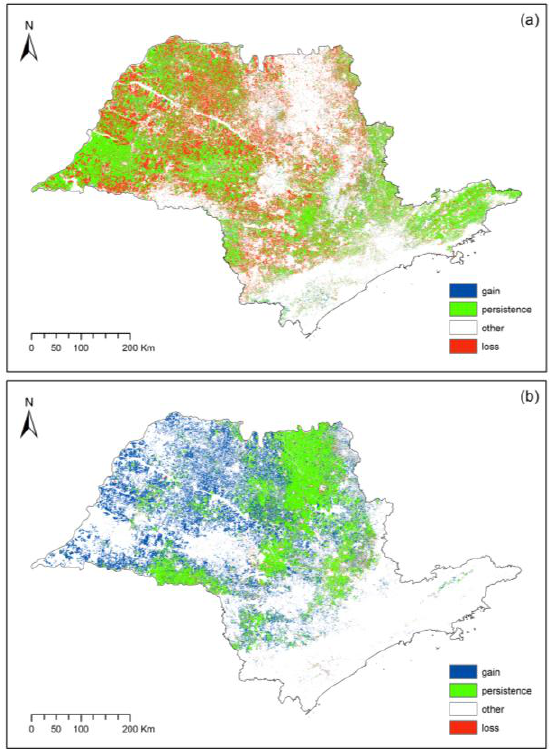
Figure 3. Change in the Pasture (a) and Agriculture (b) categories between the years 2000 and 2015. In this figure, Agriculture encloses the categories ‘Annual and Perennial Crop’ and ‘Semi-perennial Crop’ of the original categories (respectively, ID’s 19 and 20 of Table